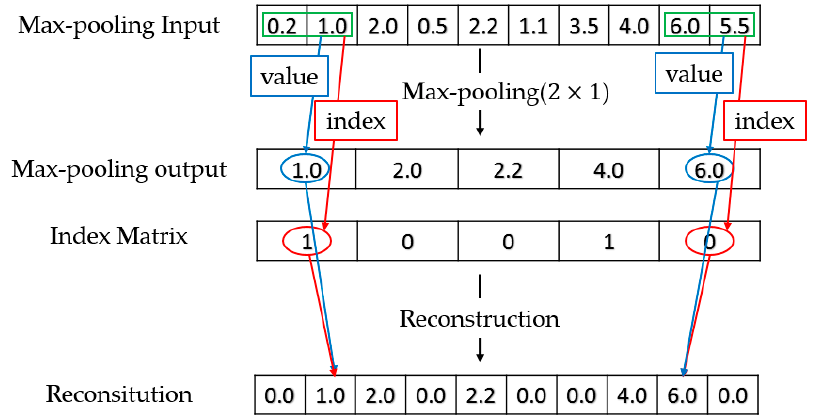
Figure 3. Max-pooling and Reconstruction.